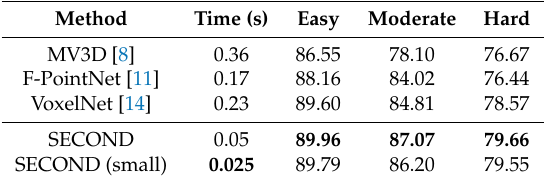
Table 5. Bird’s eye view detection performance: Average precision (AP) (in %) for BEV boxes in the KITTI validation